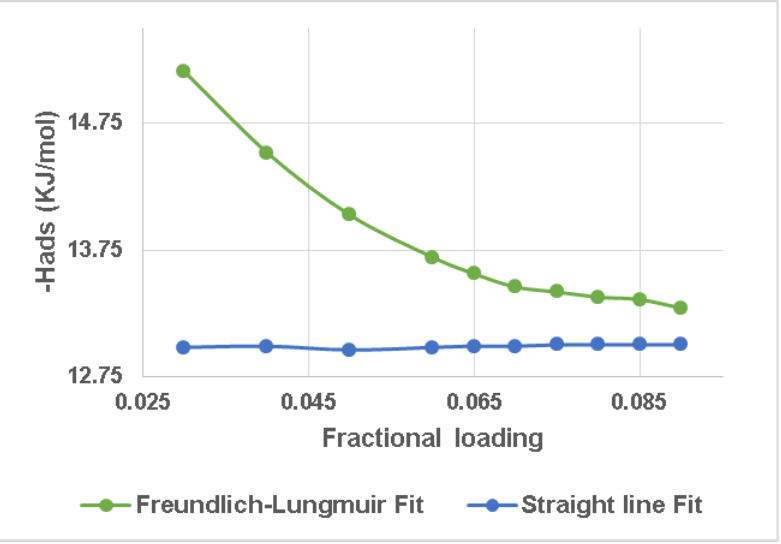
Figure 4. Isosteric heat of adsorption found between vapour uptake and silica gel.